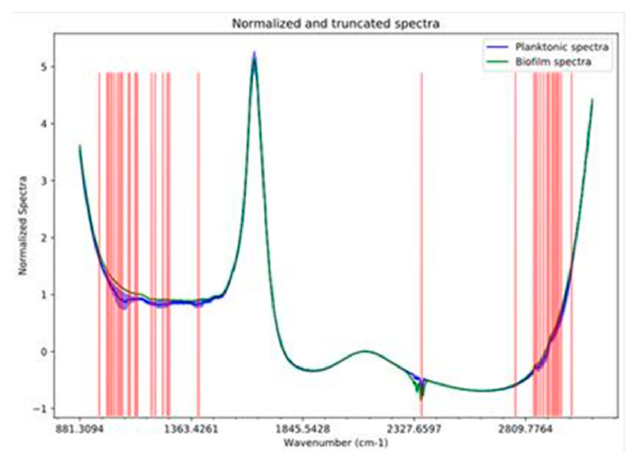
Figure 5. Fourier-transform infrared spectroscopy of attached and planktonic cells supernatant of 11 strains and 6 independent cultures of B. bruxellensis . Vertical red lines indicate the important and selected wavenumbers.